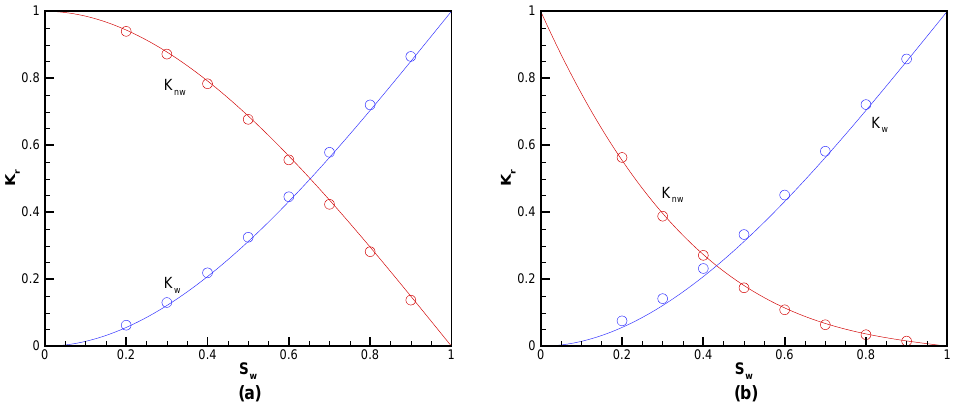
Figure 1. Relative permeabilities as a function of wetting phase saturation for two-phase concurrent flow in a 2D channel for ( a ) λ = 1 and ( b ) λ = 0.1. The open circles represent the simulation results, and the solid lines are the analytical solutions from Equation